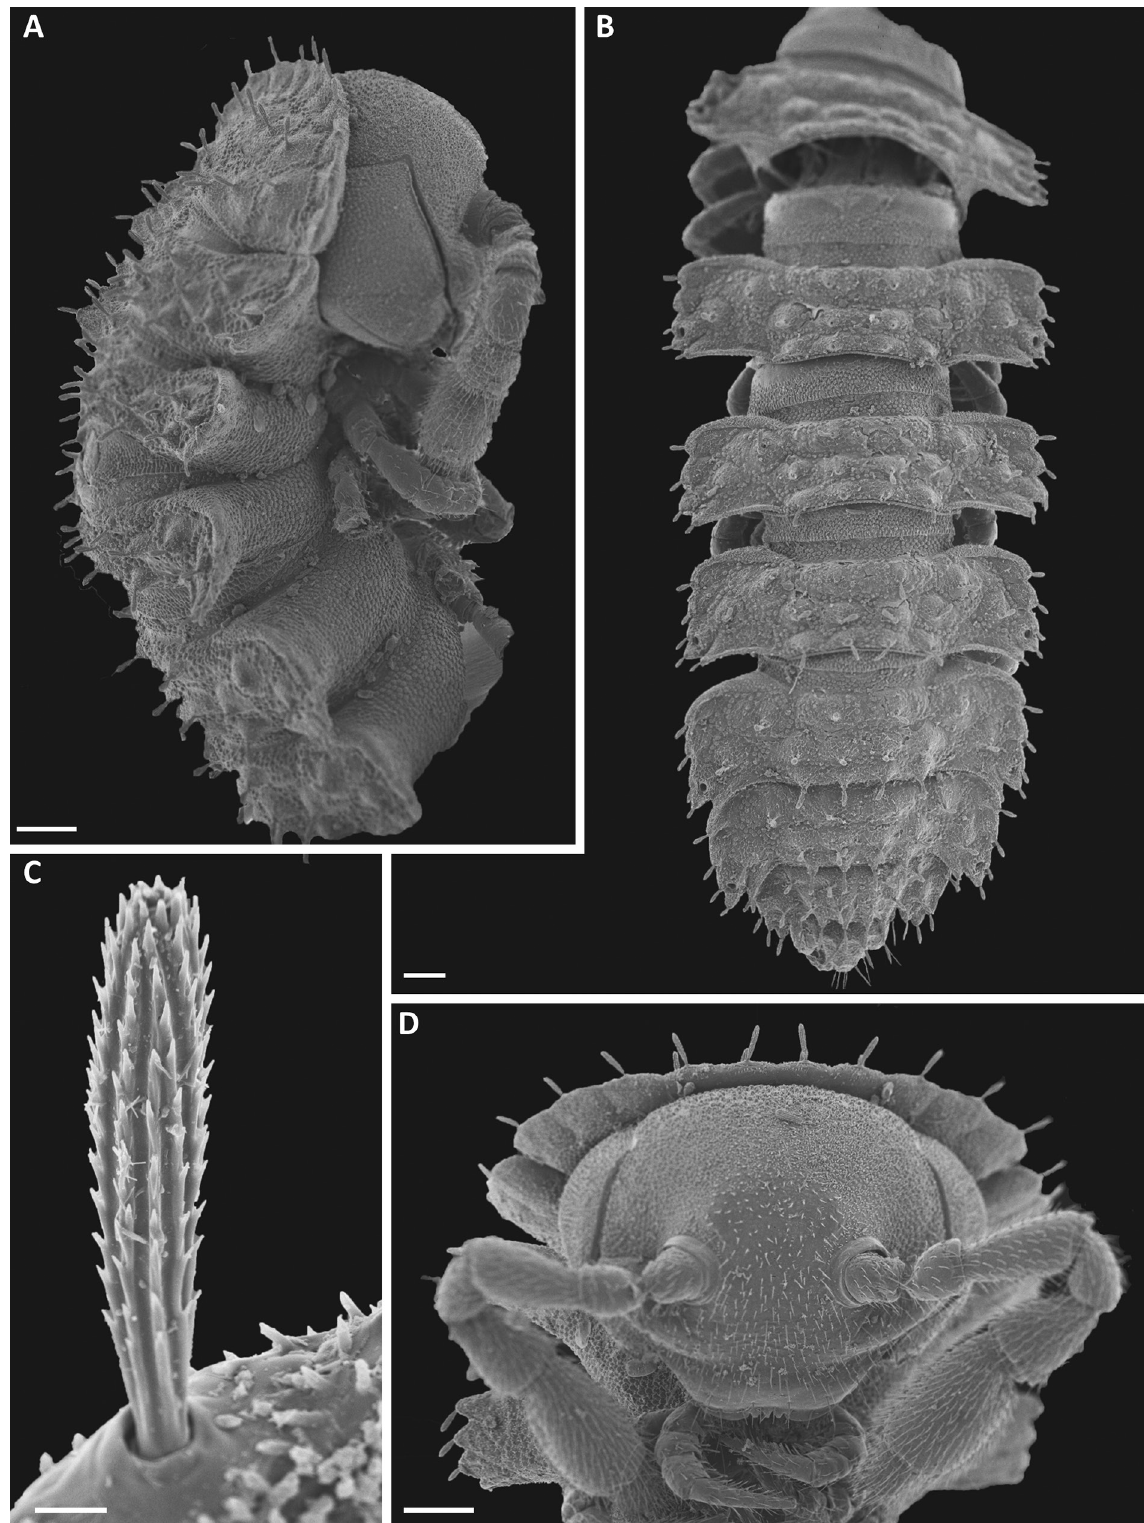
Fig. 8. Cryptocorypha cactifer sp. nov., paratype (NHMD 621836), ♂, from Mito Mitatu. A . Head and rings 1–6, lateral view. B . Rings 12–18 and telson, dorsal view. C. Tergal seta. D . Head and collum, frontal view. Scale bars: A–B, D = 0.1 mm; C = 0.005